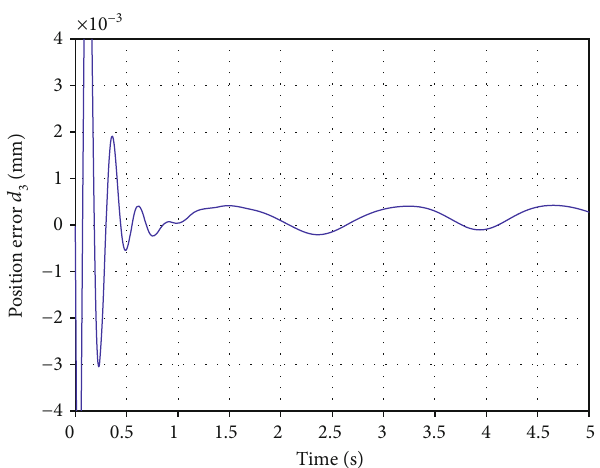
Figure 11: The driving force error of the second actuated joint. . 3